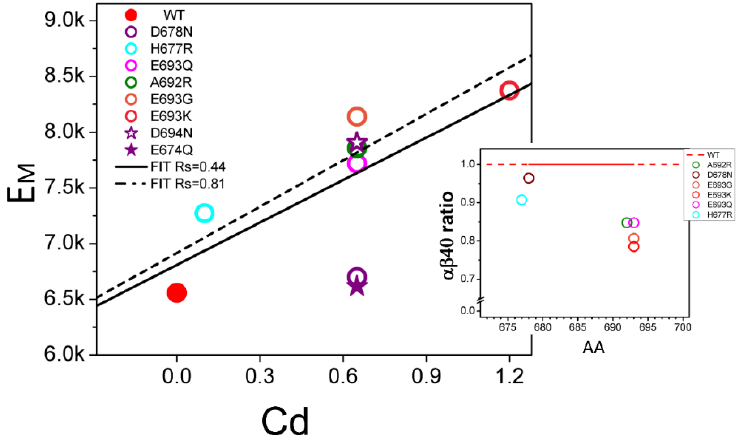
Figure 3. Effect of non-amyloidogenic FAD mutations in APP located in H ECM domain of A β . The value of c d for FAD APP mutations in H ECM domain of A β is the difference in charge resulting from mutations and calculated at isoelectric point of wild type A β 40. D694N and E674Q are artificial mutations used for control calculations. The linear fits yield regression coefficient Rs = 0.44 (sold line, all mutants data) and 0.81 (dashed line, with D678N replaced with D694N). The insert shows predicted changes in the ratio of soluble and membrane-associated A β 40 peptides ( αβ s ratio) resulting from non-amyloidogenic FAD APP mutations in in H ECM domain of A β